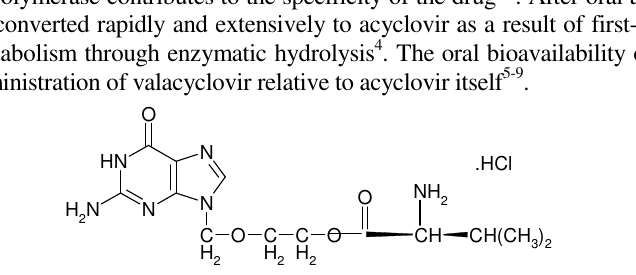
Figure 1 . Structure of valacyclovvir